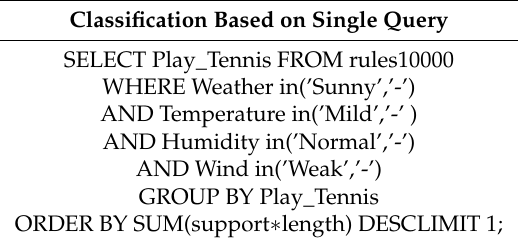
Table 11. Sample of random generated classification